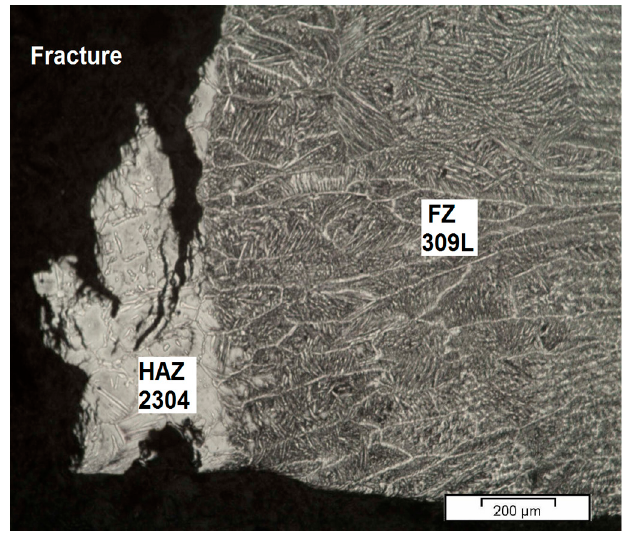
Figure 2. Microstructure of dissimilar weldment with 309L weld metal showing stress corrosion cracks in the heat affected zone (HAZ) on the 2304 duplex stainless steels (DSS) side.